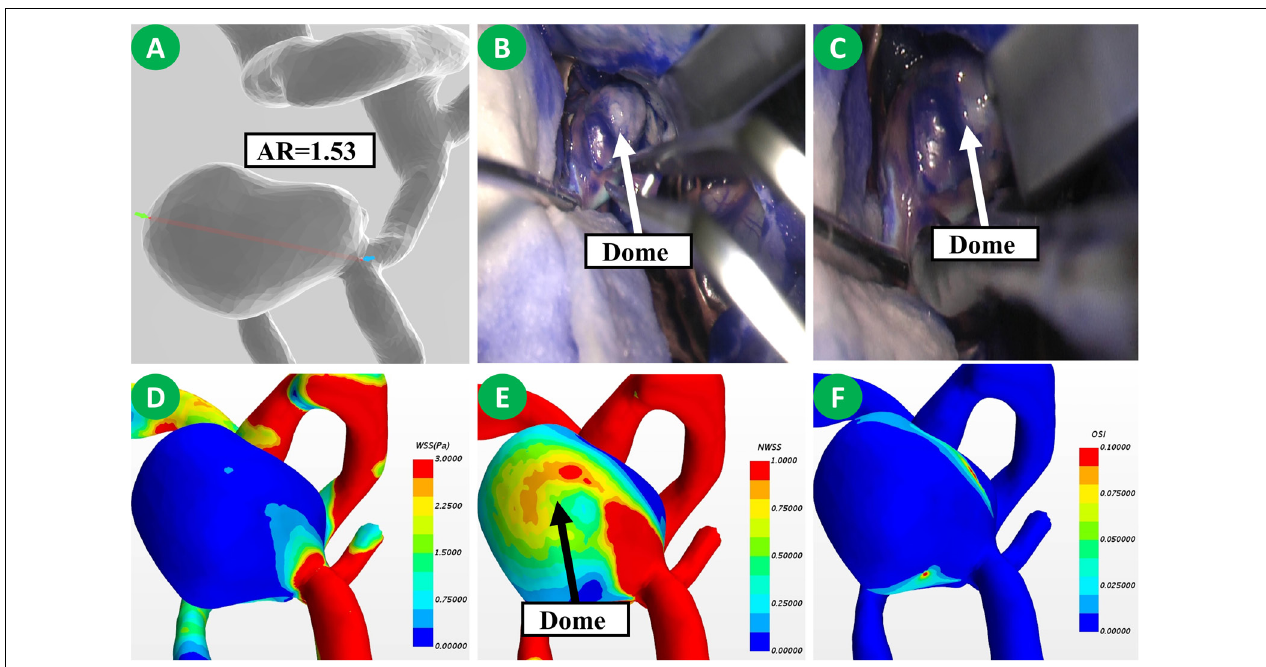
FIGURE 2 | This is a patient with non-IOR aneurysm. Its AR was 1.53 (A) . Uneven thickening of the dome of the aneurysm was observed during the operation (B) . There existed no rupture during clip application (C) . Based on the hemodynamic analysis, the dome of the aneurysm has a low WSS but a higher NWSS (D,E) . No significant increase of OSI was observed (F) .